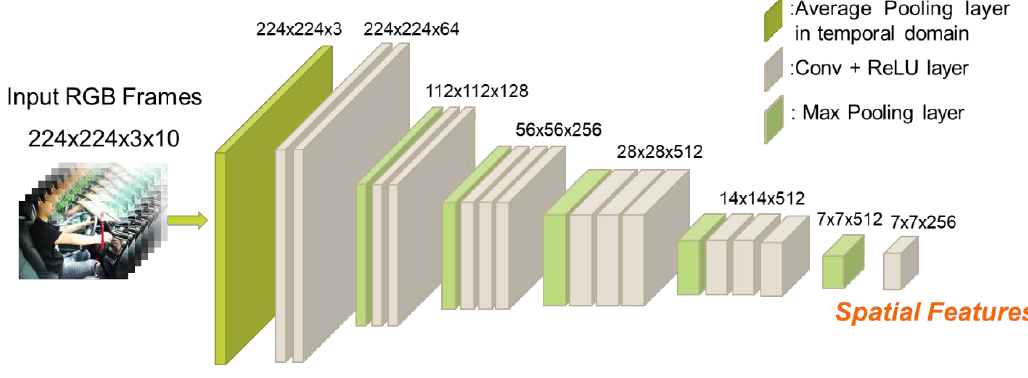
Figure 2. Configuration of spatial stream ConvNet.